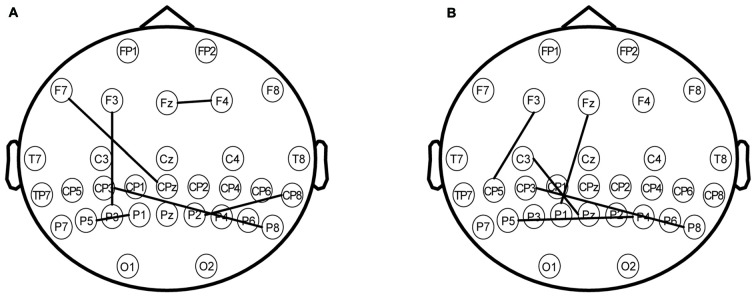
(A) The phase synchronization of electrodes under the theta frequency band. The significant difference between rTMS and sham with phase locking value (PLV) on the map (P < 0.01**) involved the following coupling brain areas: the prefrontal area (electrodes including F7, F3, Fz and F4), the parietal area (electrodes including CP3, CPz, TP8, P5, P3, P1, P2 and P8). (B) The phase synchronization of the electrodes under the alpha frequency band. The significant difference between rTMS and sham with PLV on the map (P < 0.01**) involved the following coupling brain areas: the left prefrontal area (electrodes including F3 and Fz), the left central area (electrodes including C3), the parietal area (electrodes including CP5, CP3, P5, P1, Pz, P4 and P8).